Question: Sum up the contents of this chart in one sentence.
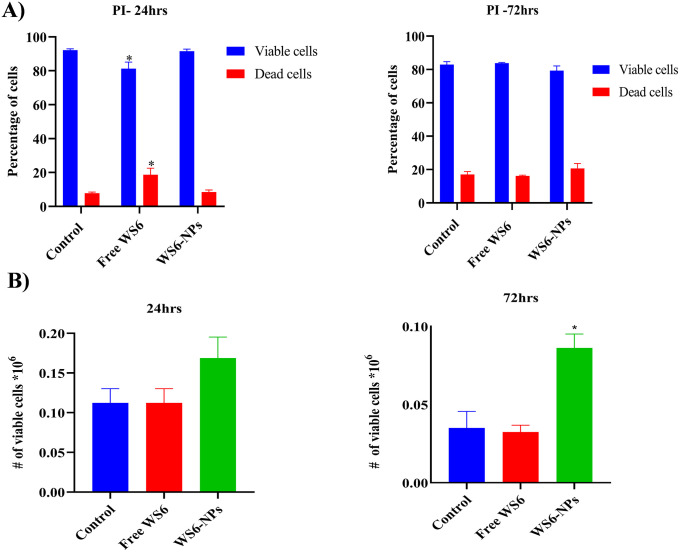
Answer: Viable/dead cells discrimination by: A) flow cytometry analysis of percentage of viable and dead cells stained with propidium iodide (PI), B) Cell count by trypan blue, of stem cells from apical papilla (SCAP) treated with 1 µM of free WS6 and WS6-loaded NPs for 24hrs and 72hrs. A two-way ANOVA test was used for statistical analysis for PI staining and a one-way ANOVA for cell counting (* < 0.05). (N = 3).Bars represent means ±SD.